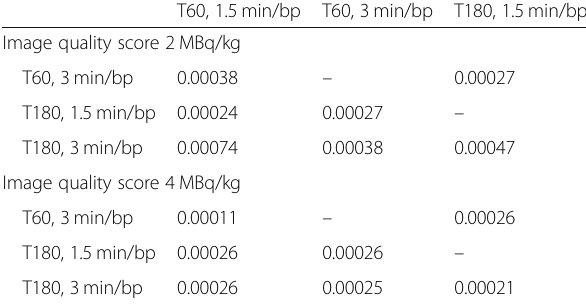
Table 4 p values of the pairwise comparison of the image quality scores within the 2 MBq/kg group and the 4 MBq/kg group for all sets of reconstructed images. p values < 0.05 were considered statistically significant